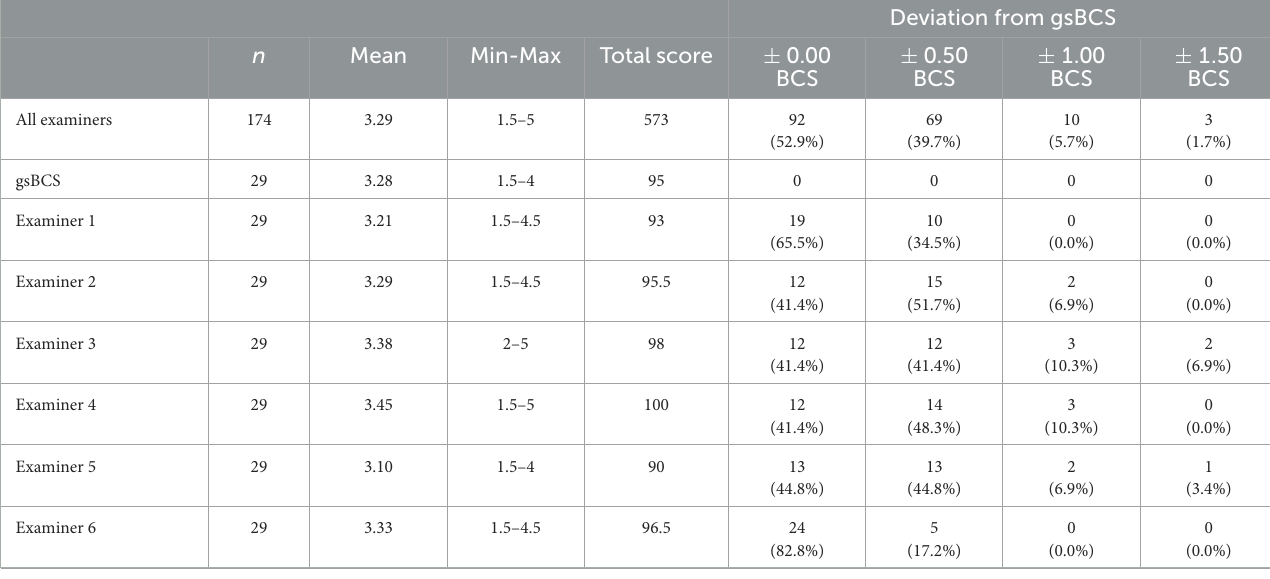
TABLE 2 Overview of the results of each examiner and the number of assessed Body Condition Scores (BCS) that deviated from the gsBCS (gold standard BCS).